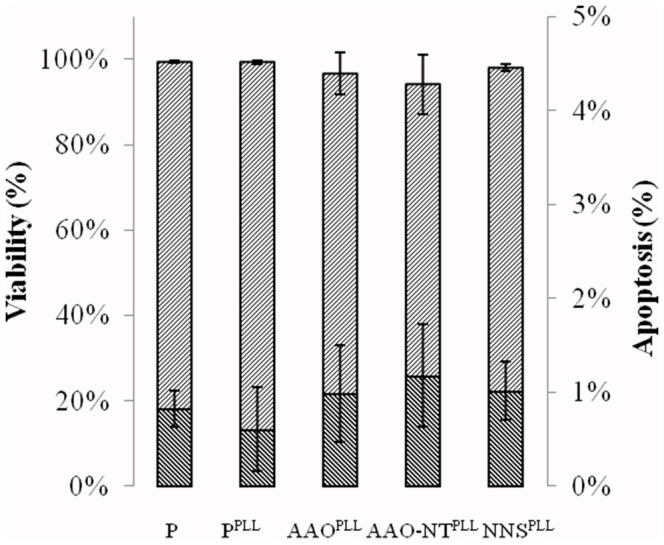
Viability and apoptosis of NIH-3T3 on P, PPLL, AAOPLL and AAO-NTPLL and NNSPLL.Cell viability (p = 0.087). Cell apoptosis (p = 0.309). N = 6. Kruskal-Wallis followed by multicompare analysis.